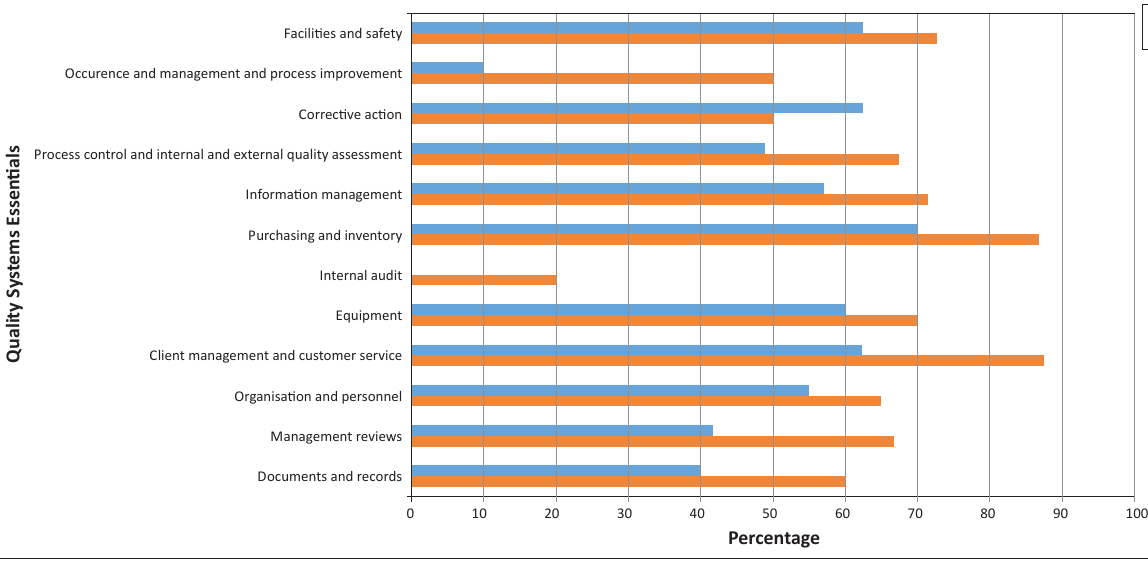
FIGURE 2: Mean QSE scores at the baseline and exit audits, Botswana SLMTA programme 2010-2011 ( n = 7).